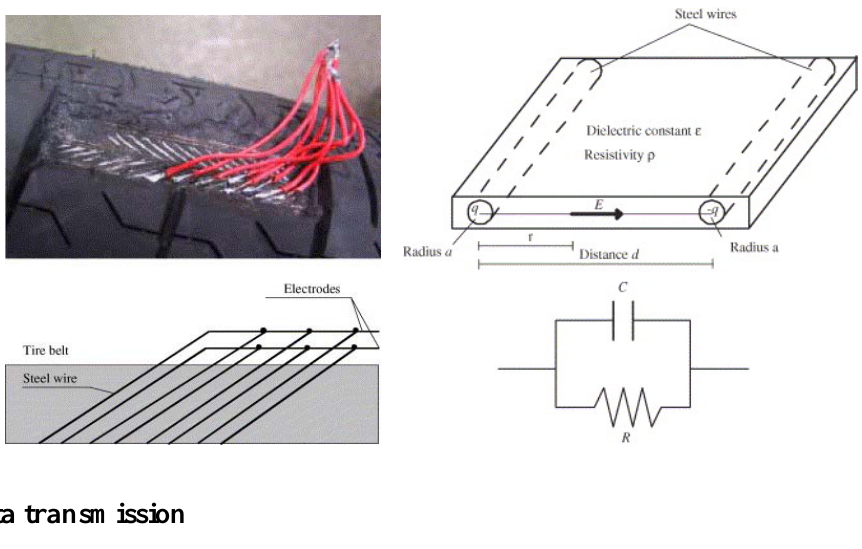
Figure 4. Self-sensor modeling of a steel wire belt in a radial tire as an electric resistor– condenser parallel circuit. The diagram is from Matsuzaki et al . [79] and is reprinted with permission from